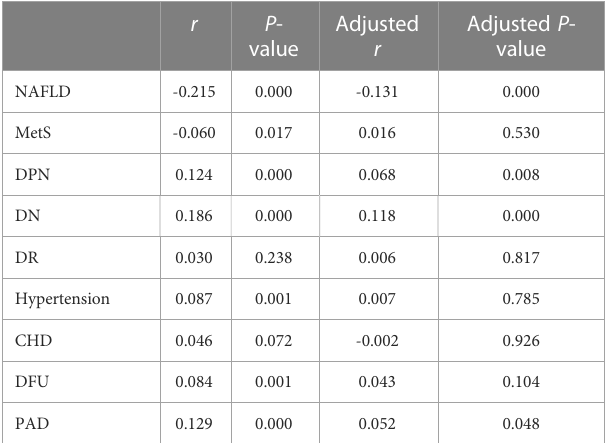
0.618; Figure 1B) and 1.402 (sensitivity: 38%; speci fi city: 81.9%; and AUC: 0.600; Figure 1C) in male and female subjects, respectively.